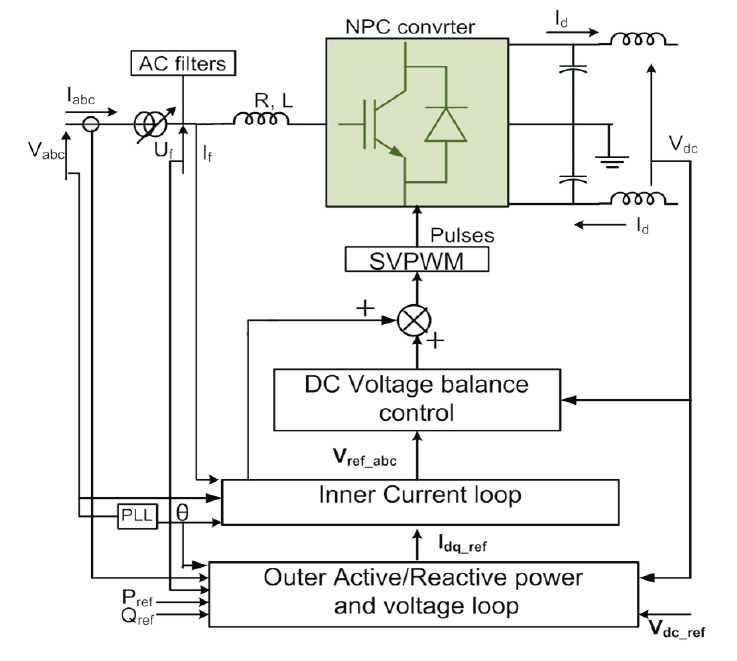
Figure 2: Control structure of a converter.